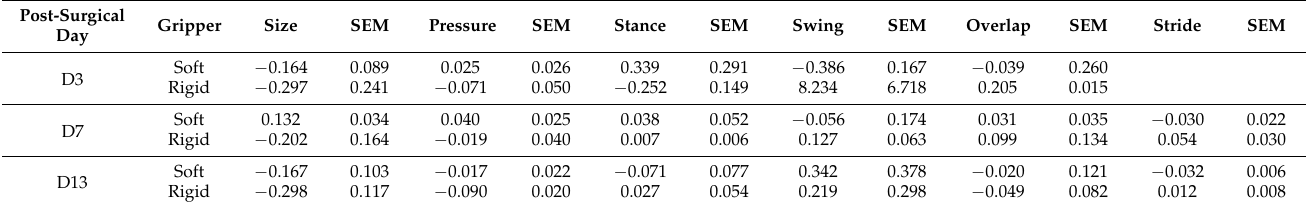
Table 1. Gait parameters of hind limb gait in soft gripper group and haemostats group. Data are expressed as mean post-surgical fold change (injured right hind limb vs normal left hind limb, SEM: standard error of the